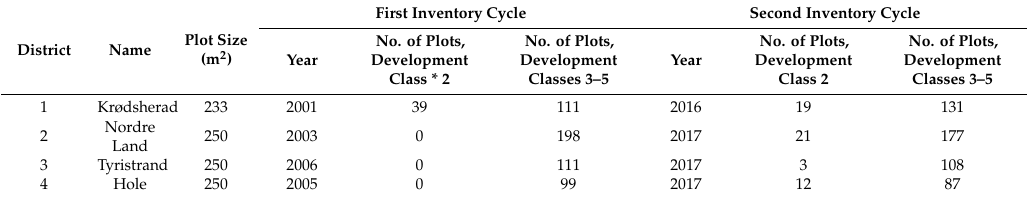
Table 1. Summary of the inventories and number of plots within forest development